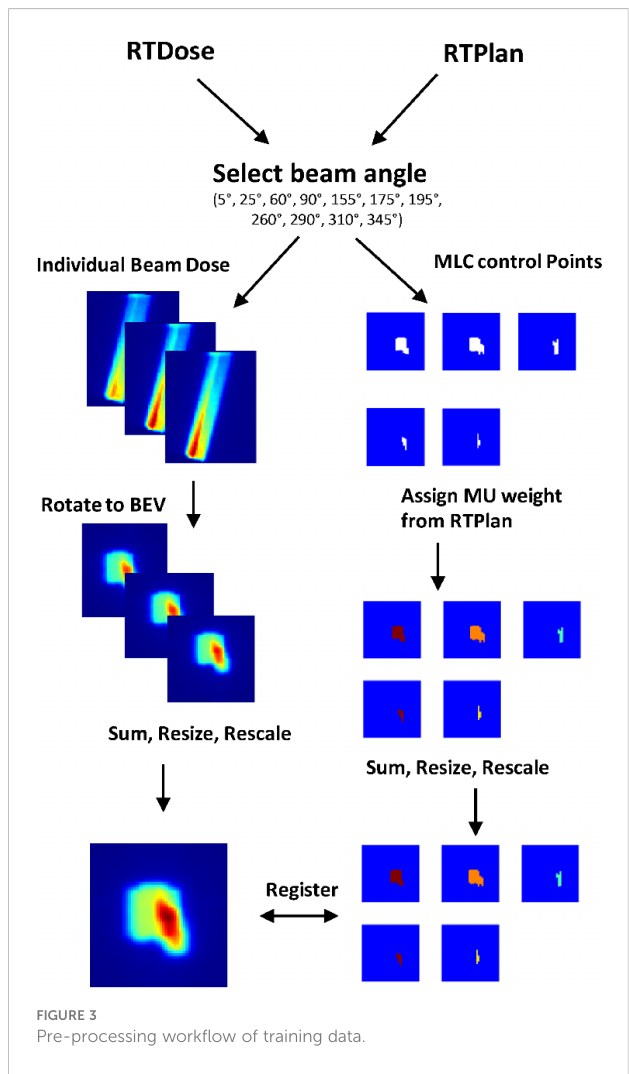
FIGURE 3 Pre-processing work fl ow of training